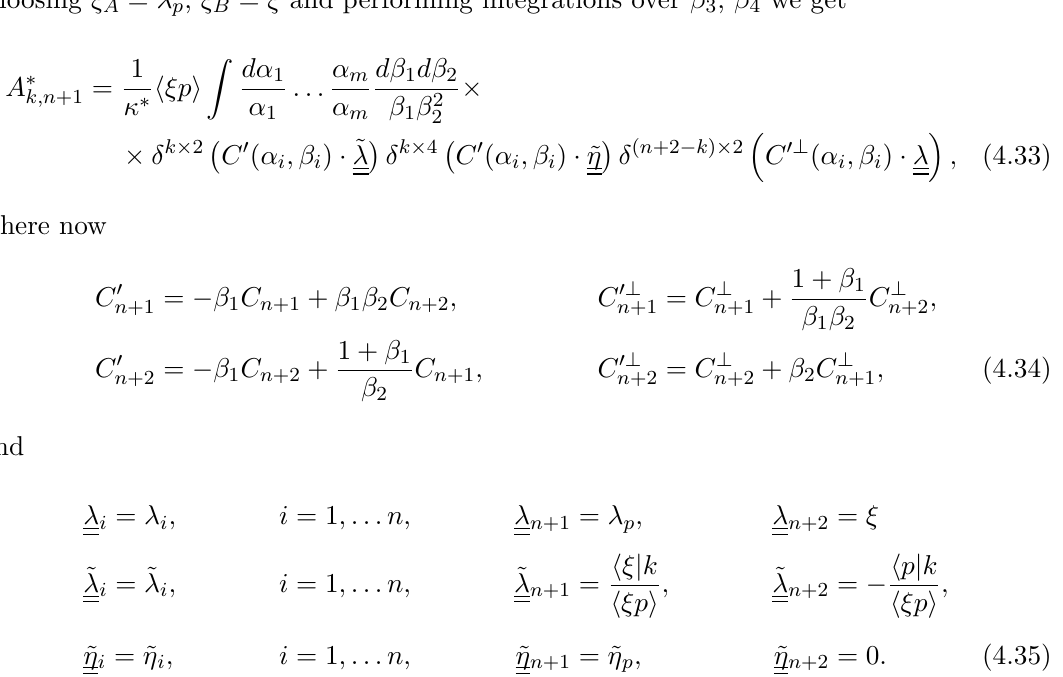
Figure 6 . On-shell sub-diagram I obtained by removing o(cid:11)-shell vertex from A (cid:3) corresponding permutation ~ (cid:27) and C